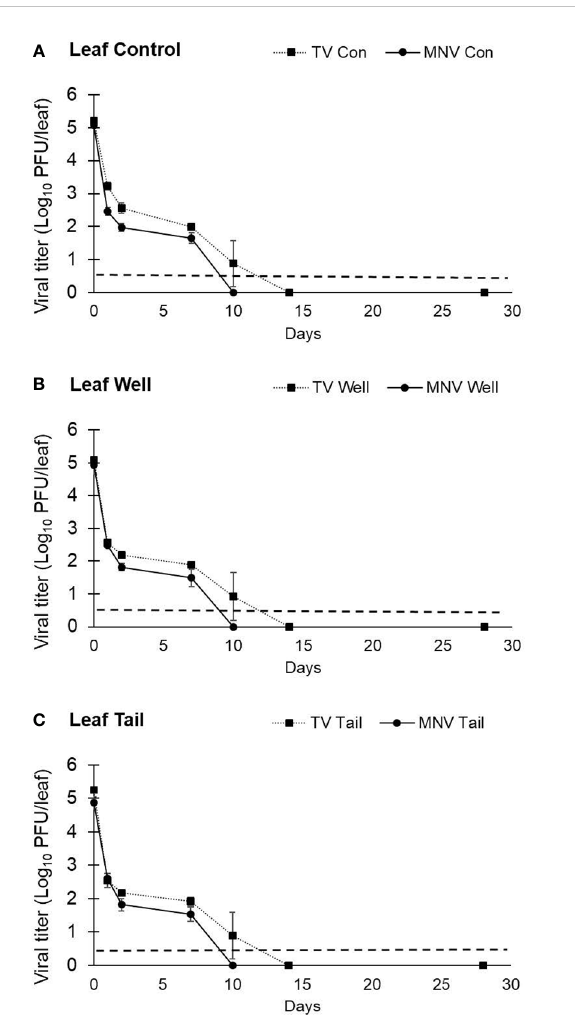
FIGURE 5 Impact of water quality on the recovery of infectious human norovirus surrogates from the surface of romaine lettuce leaves. Infectivity of TV and MNV on the surface of lettuce leaves was assessed for 28 days (trial 2) when suspended in (A) ultrapure water, (B) well water, and (C) tail water. Viral titer is reported as PFU/leaf. Data points are the average of six replicates. Error bars represent ± standard